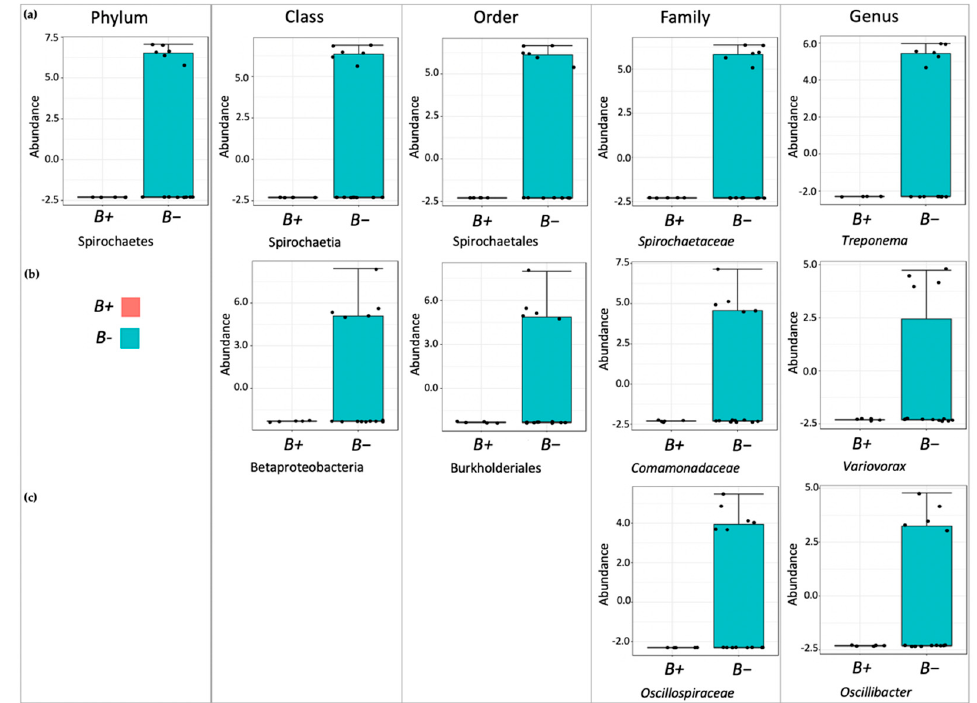
Figure 4. Boxplots showing the log transformed counts of distinguished OTUs identified by MetagenomeSeq analysis ( p < 0.05). This includes multiple taxa belonging to the same lineage: ( a ) OTUs belonging to the Spirochaetes lineage; ( b ) OTUs belonging to the Betaproteobacteria lineage; ( c ) OTUs belonging to the Oscillospiraceae lineage. Plots in blue represent the data from B − voles, red plots are from B + voles.